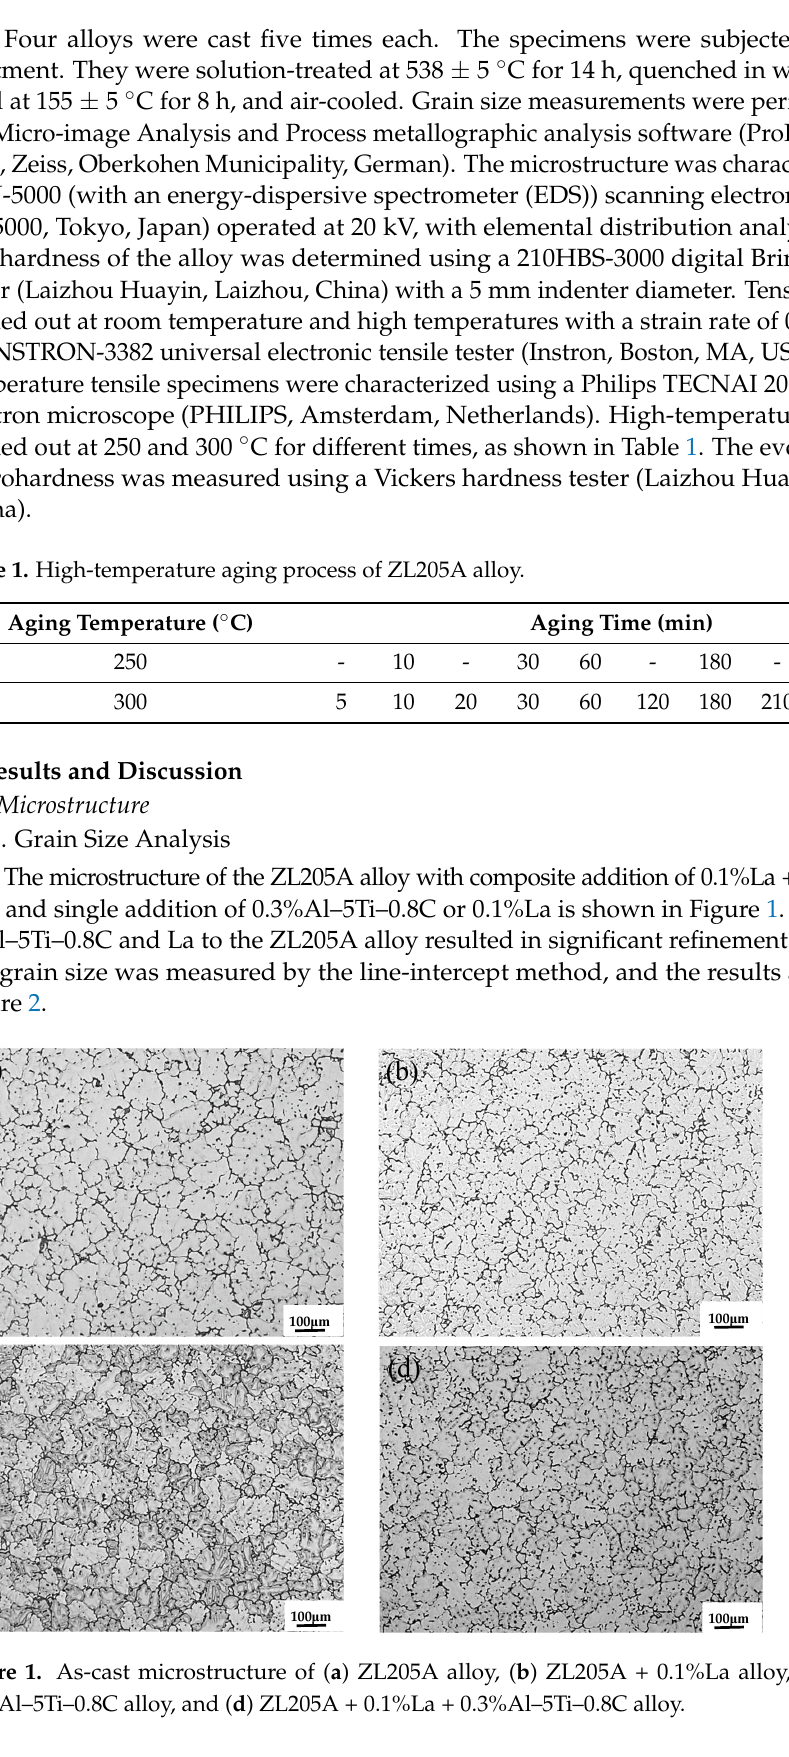
Figure 1. As-cast microstructure of ( a ) ZL205A alloy, ( b ) ZL205A + 0.1%La alloy, ( c ) ZL205A + 0.3%Al–5Ti–0.8C alloy, and ( d ) ZL205A + 0.1%La + 0.3%Al–5Ti–0.8C alloy.